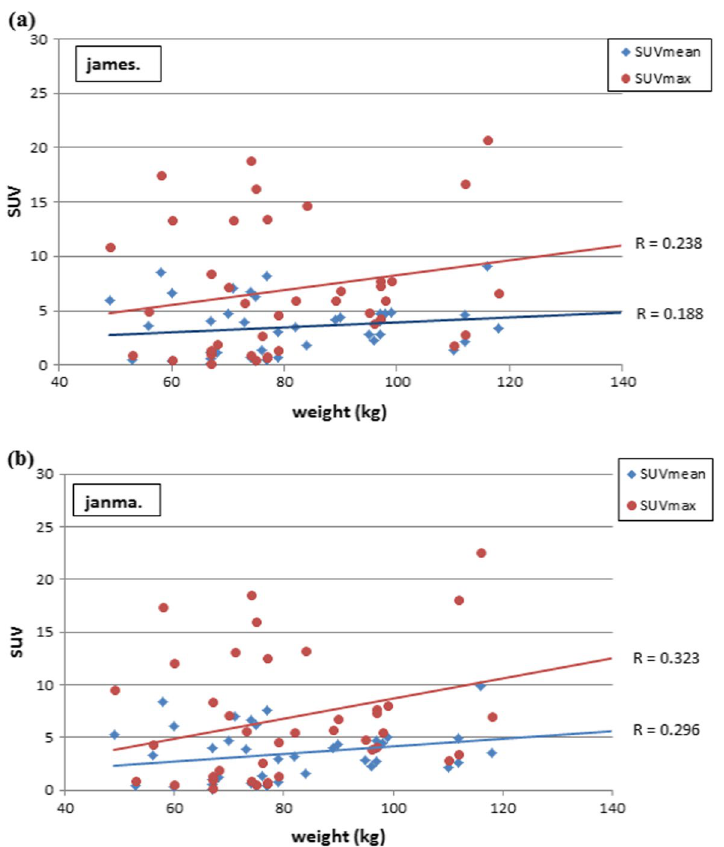
Fig. 7 Pearson correlation coefficient between Lesion SUV versus patient’s weight in kg with respect to a LBMjames and b LBM janma,